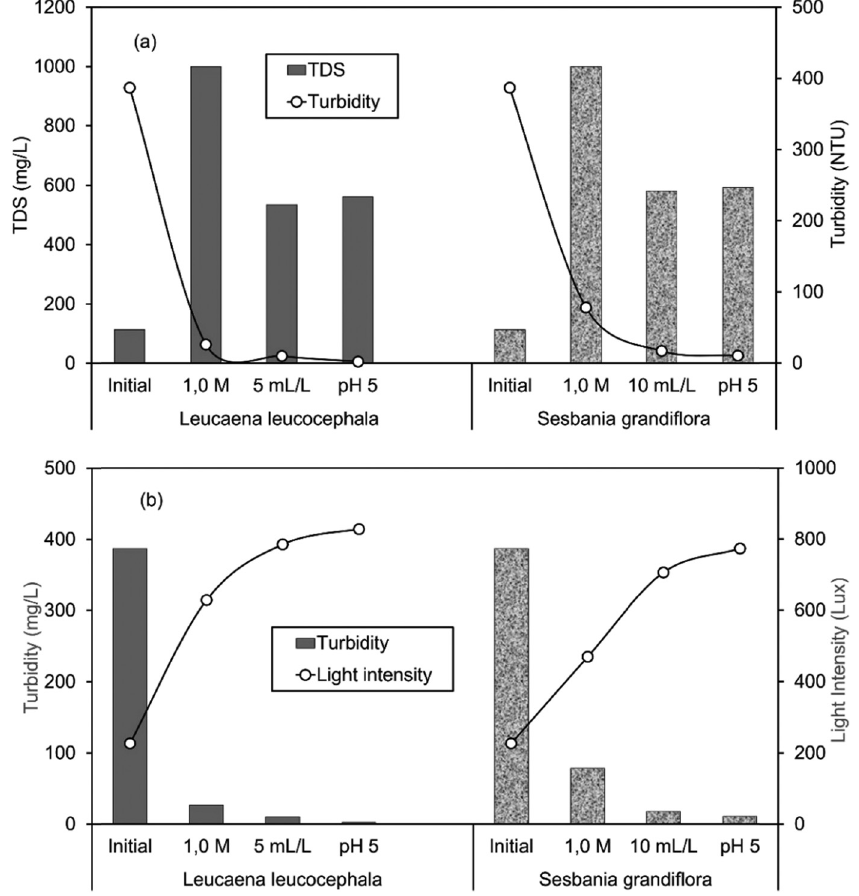
Figure 8: E ff ect of optimum conditions ( i.e., concentration, dosage, and pH ) on the removal of turbidity and TDS ( a ) and transmittance of light ( b ) in the treatment of natural